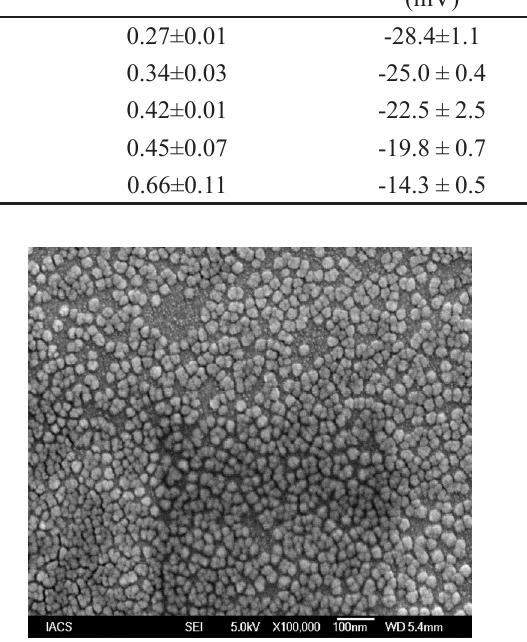
FIGURE 2 - FE-SEM of LTZ-PLGA-NPs with 10% LTZ.